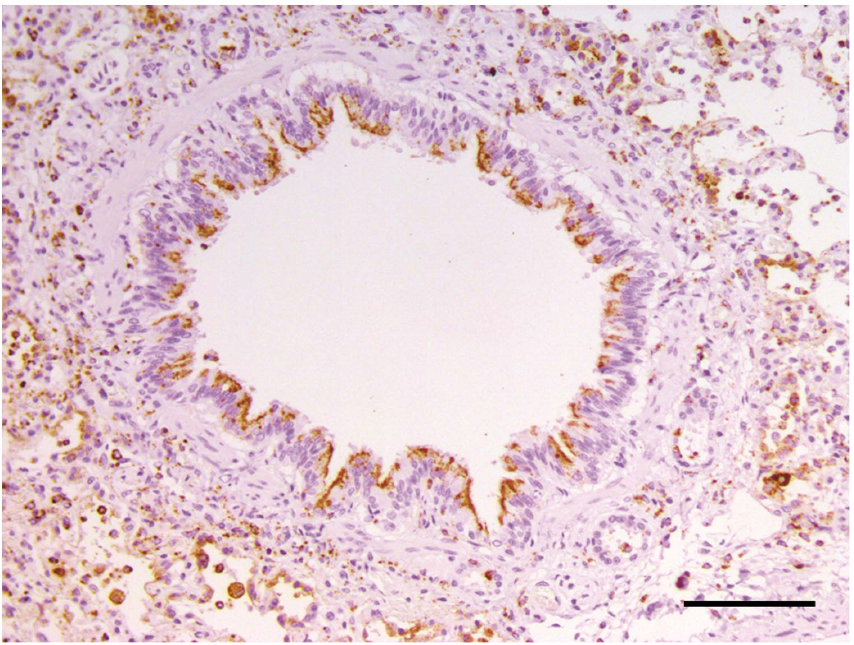
Figure 2. Immunohistochemistry (IHC) for CDV on lung tissue of wolf Wa. Bronchiolar epithelial cells and inflammatory cells filling the airways show a strong and specific CDV immuno-reactivity. Scale bar=100 m